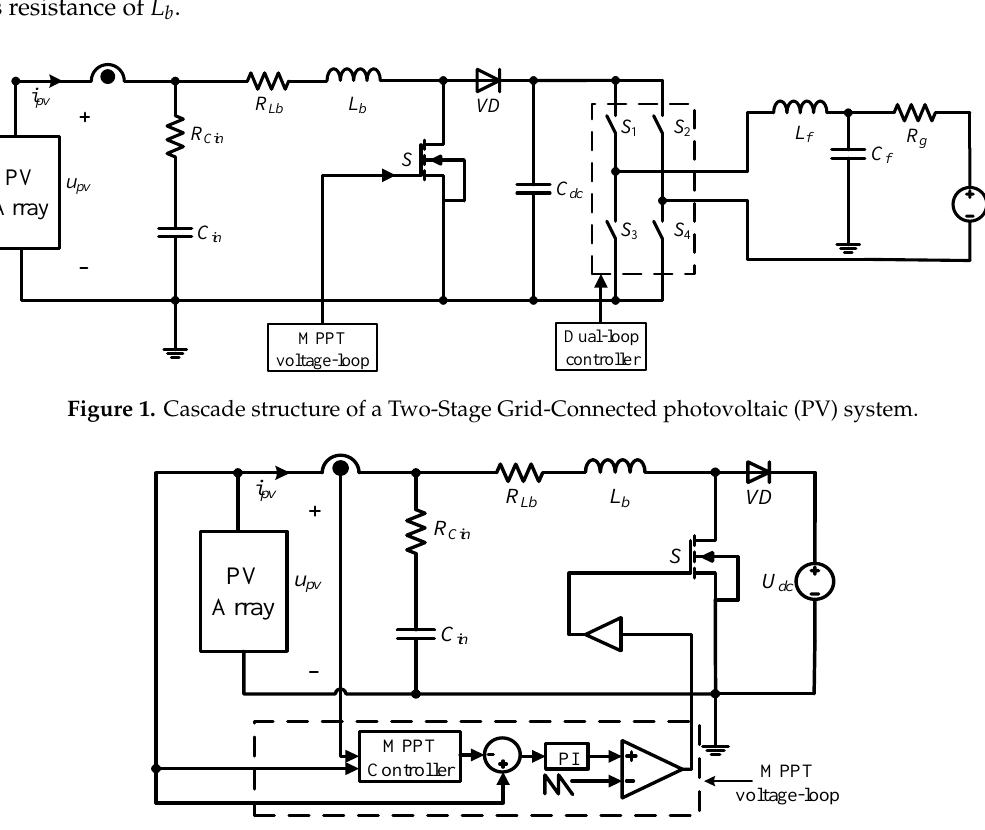
Figure 2. Schematic diagram of simplified structure of Two-Stage Grid-Connected PV system.